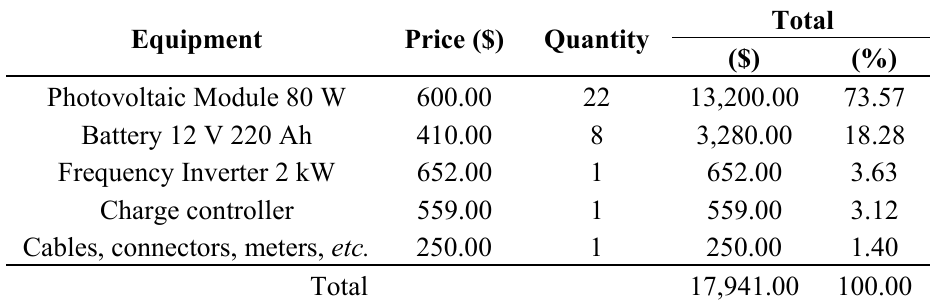
Table 6. PV system with energy storage installation cost for one residence.